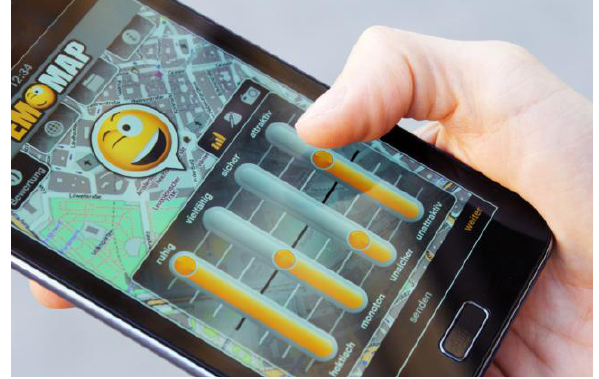
Figure 1. Screenshot of the Android application for collecting affective responses in